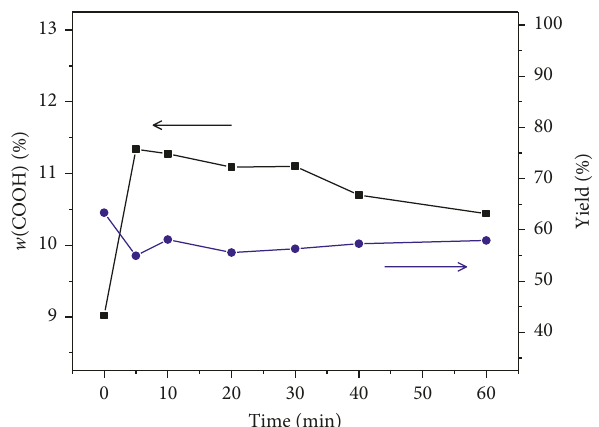
Figure 3: Effect of the reaction time on the yield and the content of carboxyl of